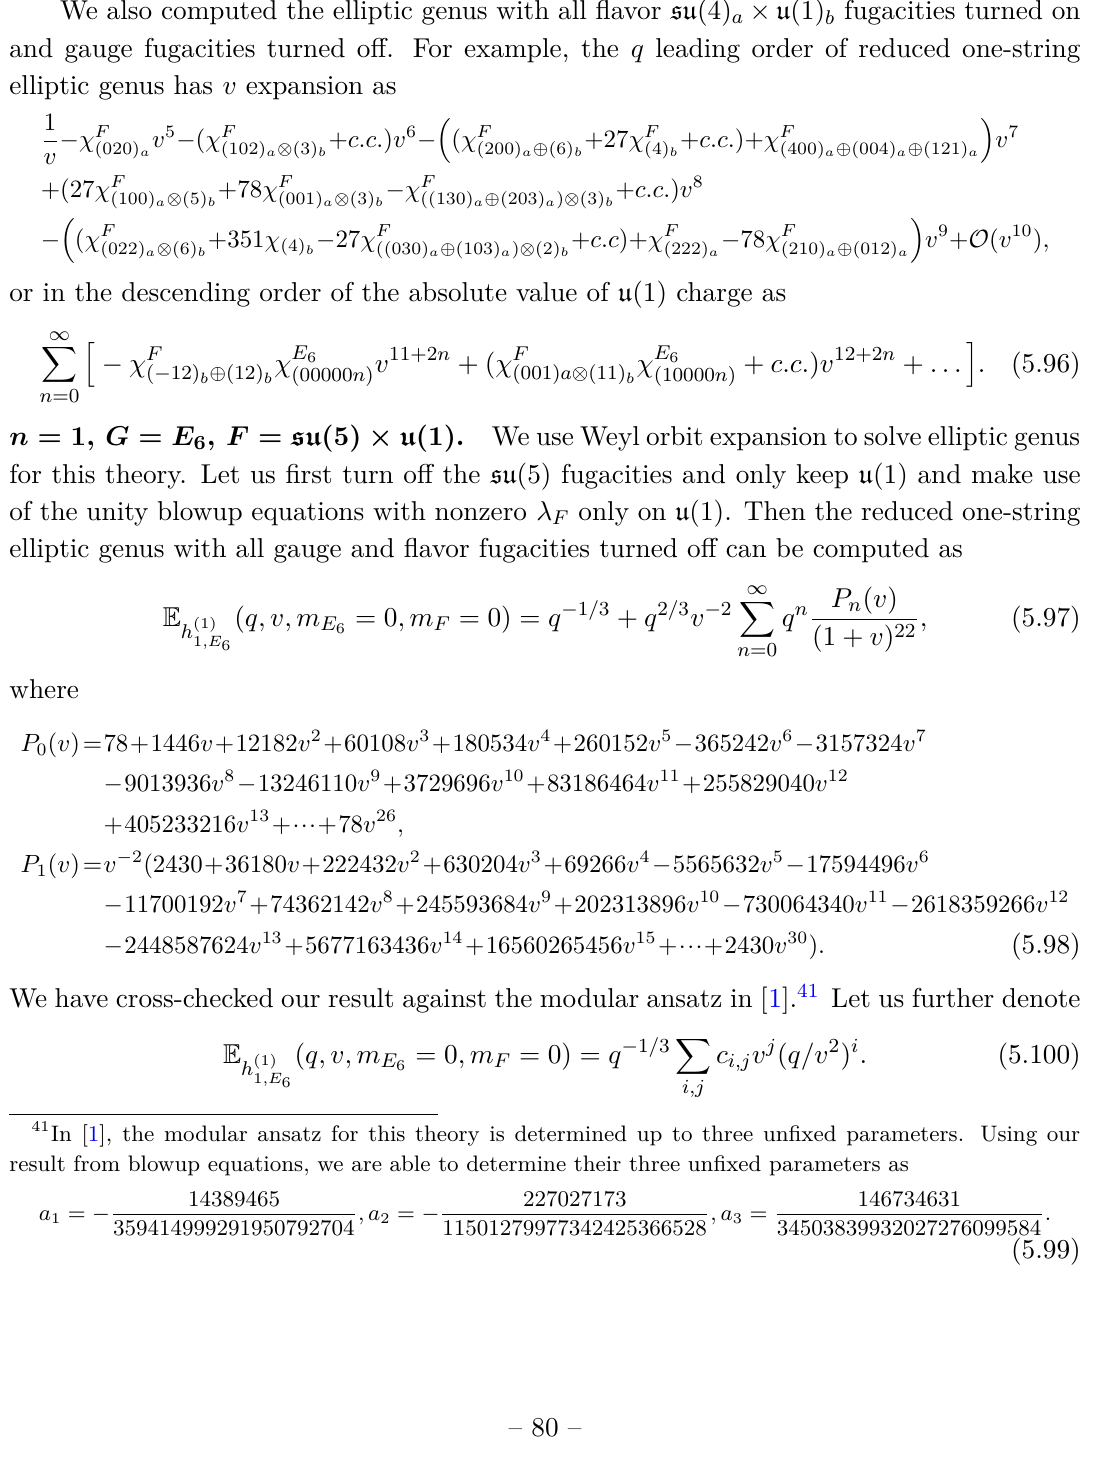
fugacities turned on × u (1) a b